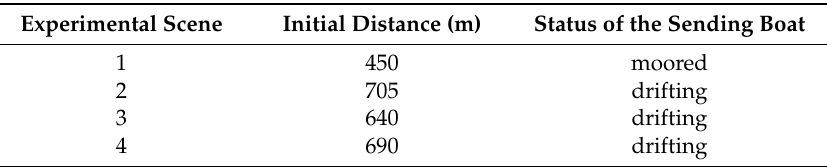
Table 3. Introduction to experimental scenes.